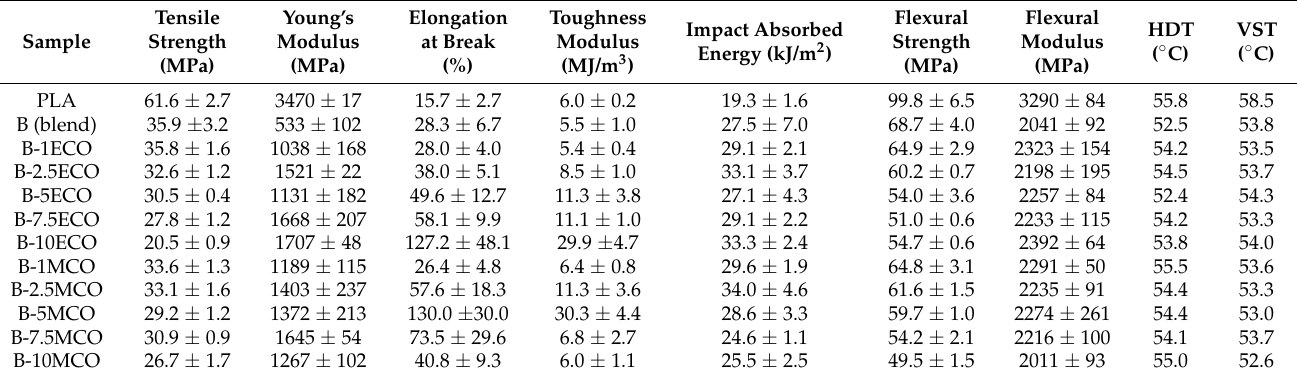
Table 2. Summary of tensile and flexural properties and HDT/VST results of neat PLA, PLA–PHB blend and plasticized blends with a different ECO and MCO